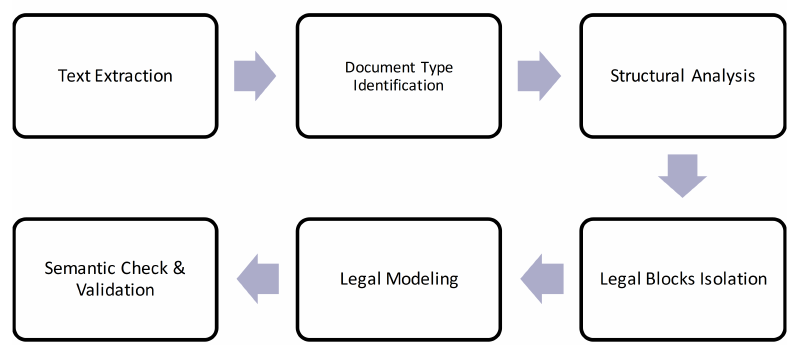
Figure 10. Parsing follows a pipeline strategy utilizing a top-down